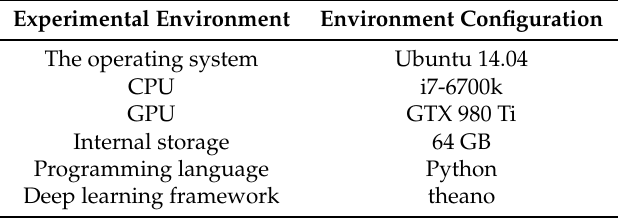
Table 1. Experimental environment and